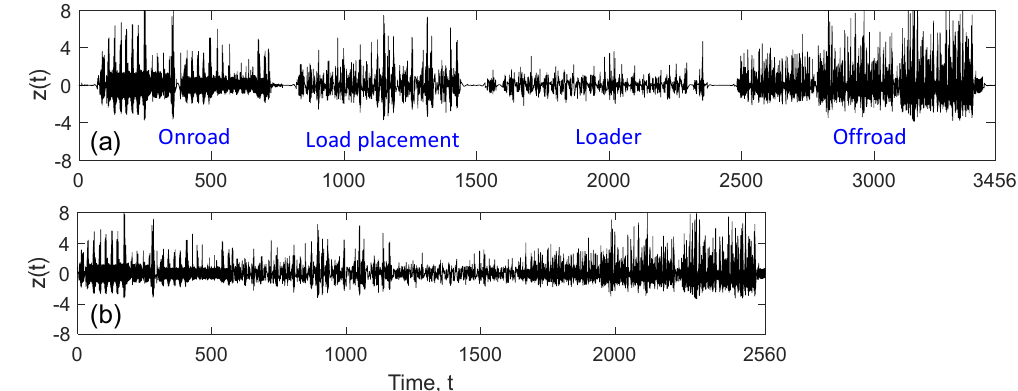
Figure 4. Location of strain gauge for channels CH4 (inner rim) and CH6 (outer rim). Reproduced from [12] with permission from Elsevier.